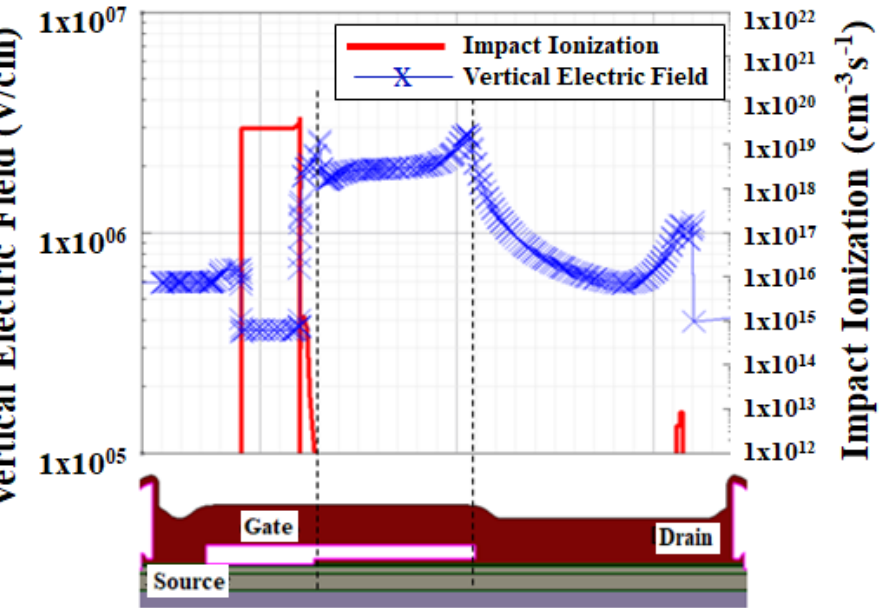
Figure 11. Simulated Impact ionization and vertical electric field distribution along the X-axis at 2DEG region in GaN HEMT device.